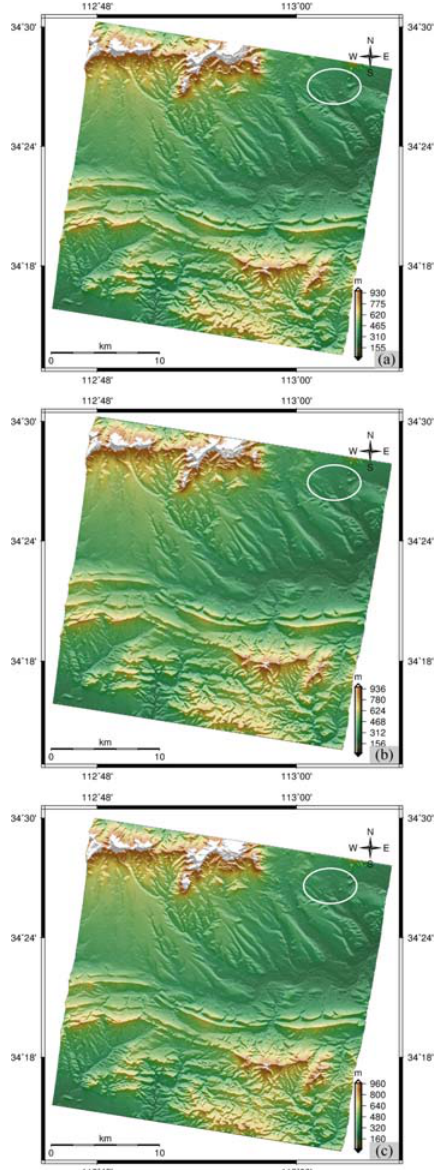
Figure 2. Gaofen-3 DEMs obtained using ML factors of (a) 8  8, (b) 4  4, and (c) 2  2. Rectangles are flat areas. Circles are the Figure 3. TanDEM-X DEMs obtained using ML factors of highest region named Laopozhai.